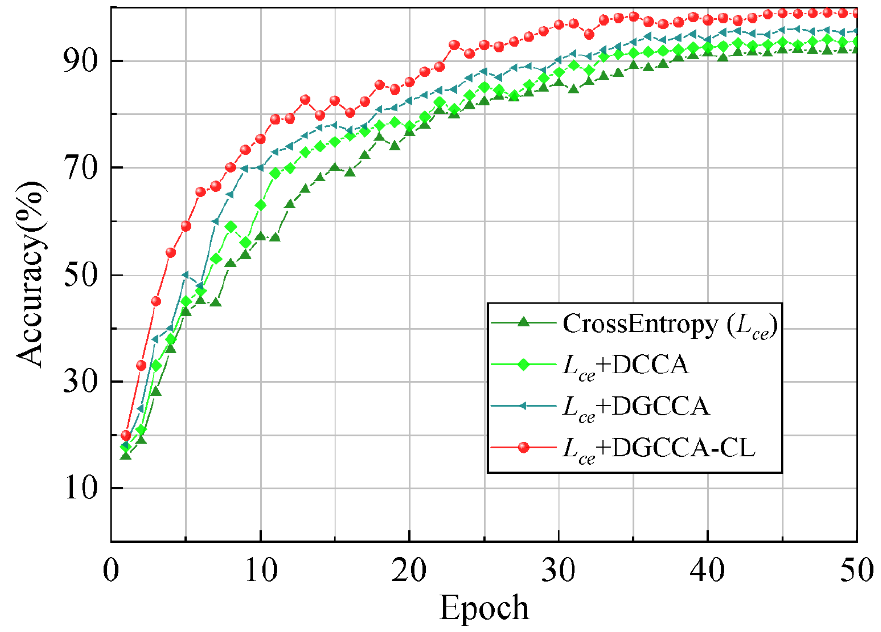
Figure 10. Recognition results of different optimization methods.